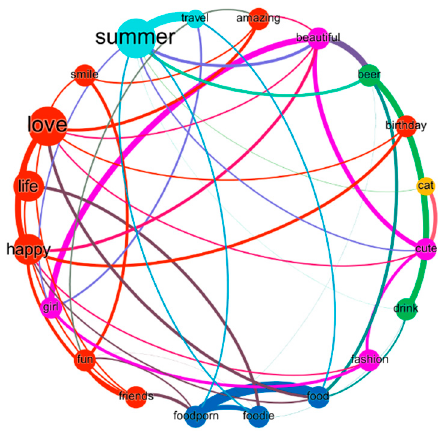
Figure 3. Semantic community discovery based on hashtag co-occurrence pattern and modularity, with node and edge size proportional to occurrence frequency, and the node color indicating community category.